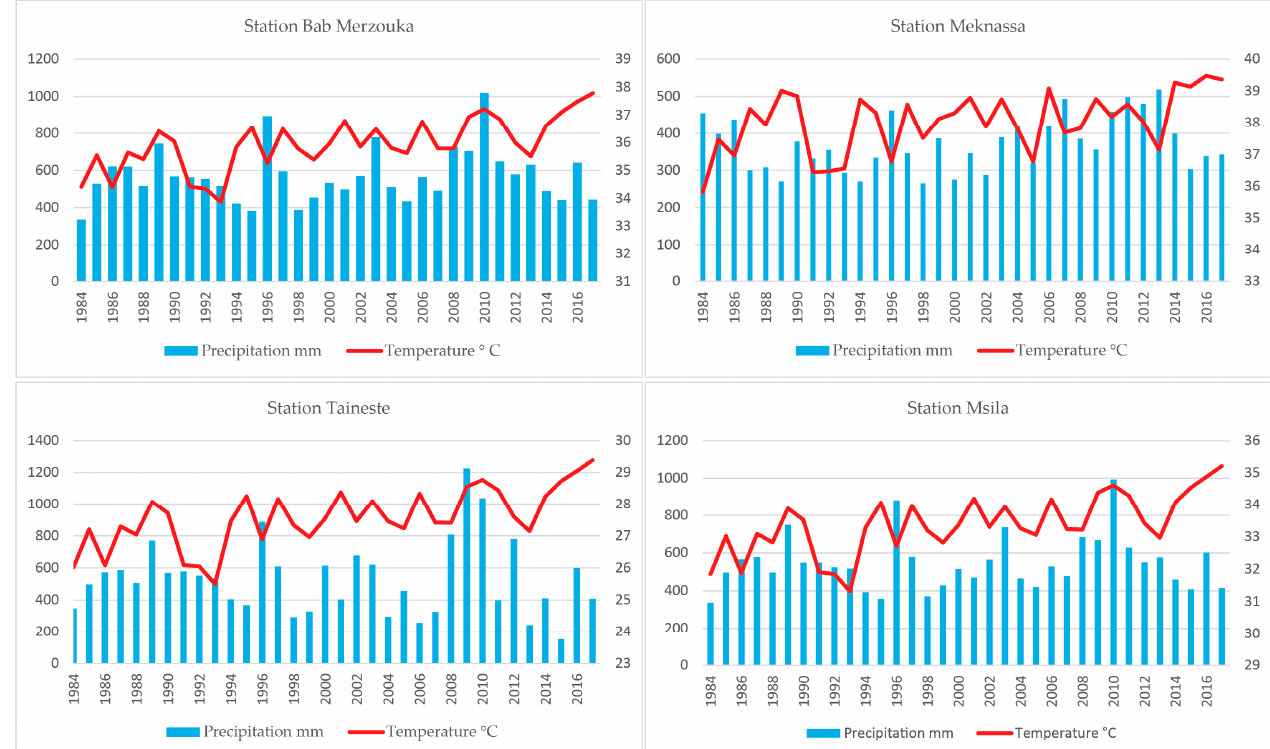
Figure 2. Mean annual precipitation (primary y-axis, blue histogram) and temperature (secondary y-axis, red curve) on the main stations of the Oued Lahdar Watershed for the period 1984–2017.